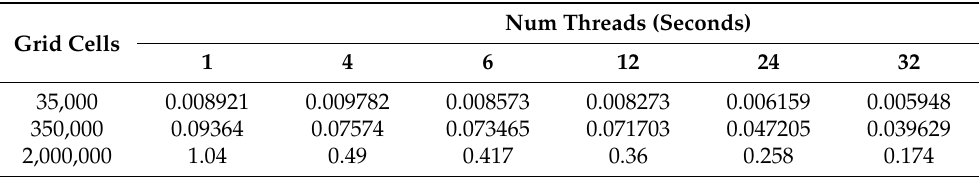
Table 2. Performance of the FDTD code running with different numbers of OpenMP threads.